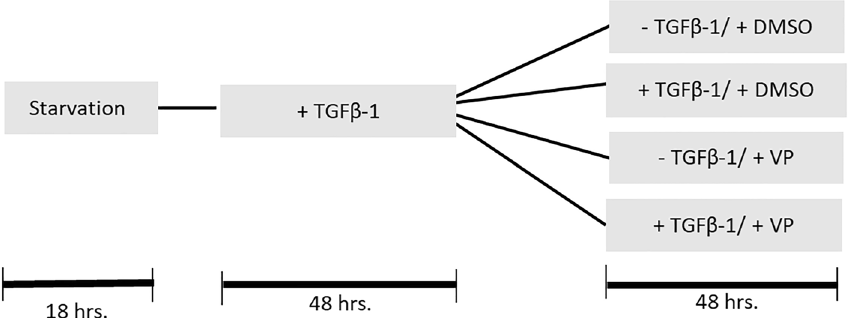
Figure 1. Schematic representation of treatments subjected to DD nodule-derived fibroblasts. DMSO is used as the control, as VP is prepared in